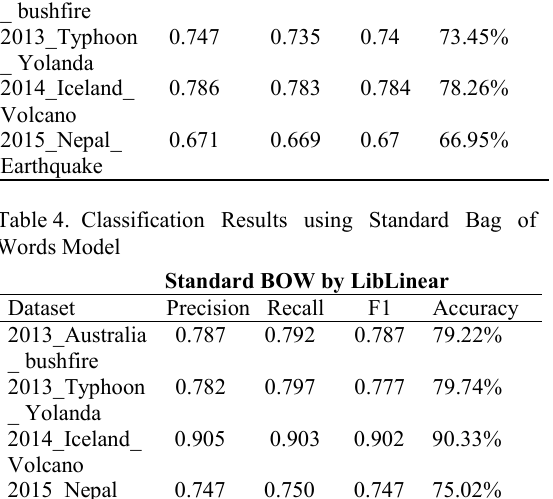
Table 6. Performance of the feature selection analysis on different datasets by SMO